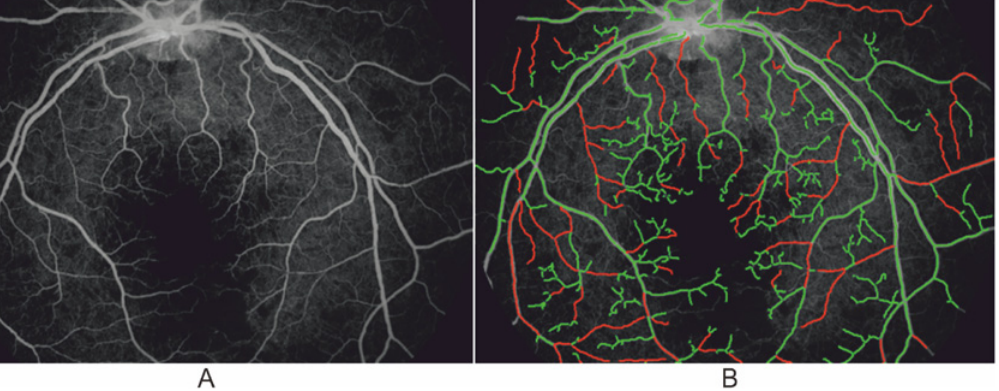
Fig 8. Illustrative vessel abnormality detection result based on the proposed segmentation method. (A) Original fluorescence angiography image. (B) Abnormality detection result. Red color indicates abnormal vessels and green color shows normal